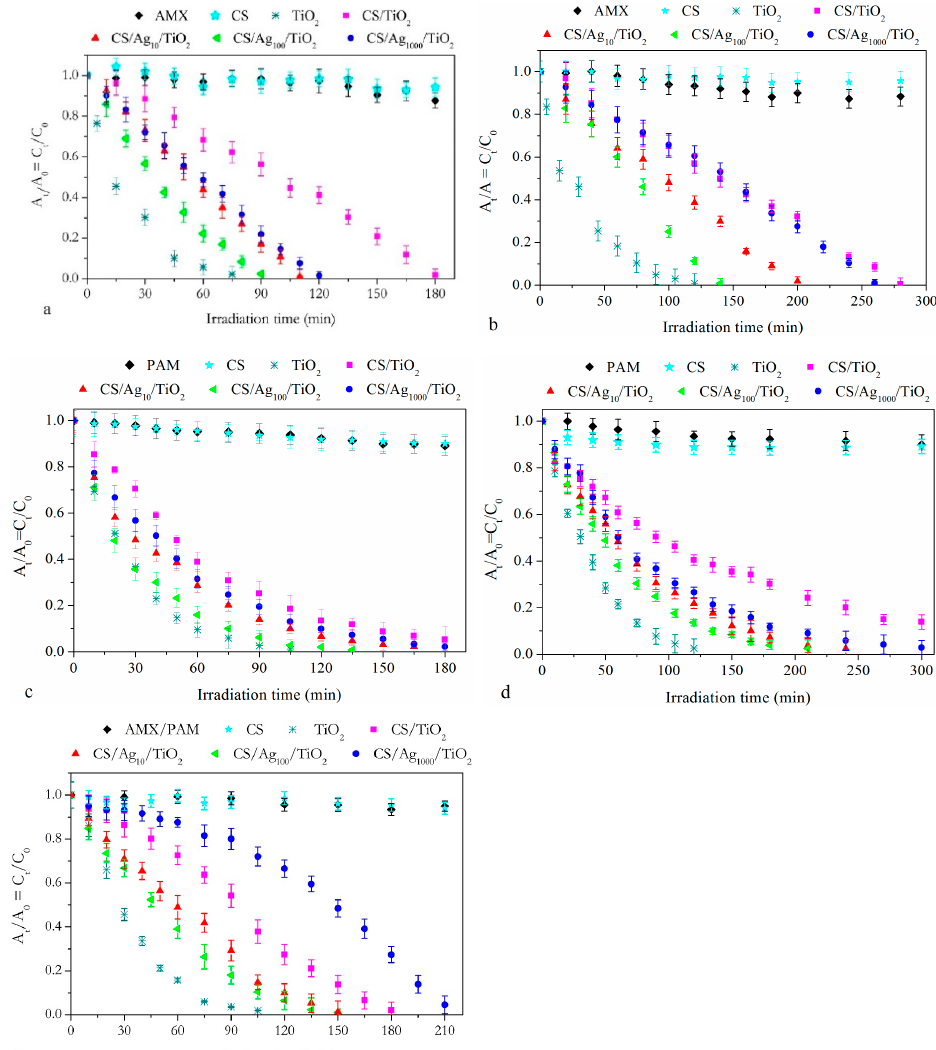
Figure 6. Photocatalysis on different catalysts and photolysis of AMX 0.01 mM ( a ) and 0.1 mM ( b ), PAM 0.01 mM ( c ) and 0.1 mM ( d ), AMX/PAM 0.1 mM ( e ) vs. time (UV–Vis light source intensity of 3.5 mW/cm 2 on the sample).